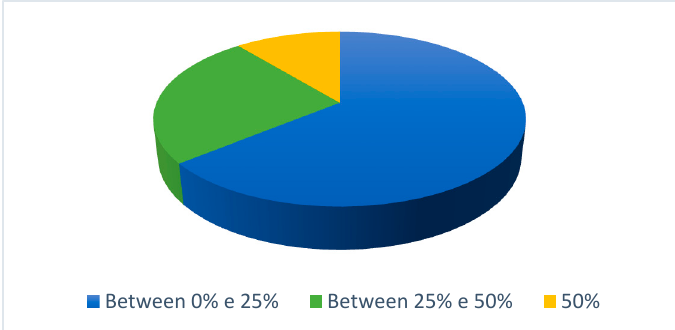
Figure 5. Percentage of workers currently teleworking.